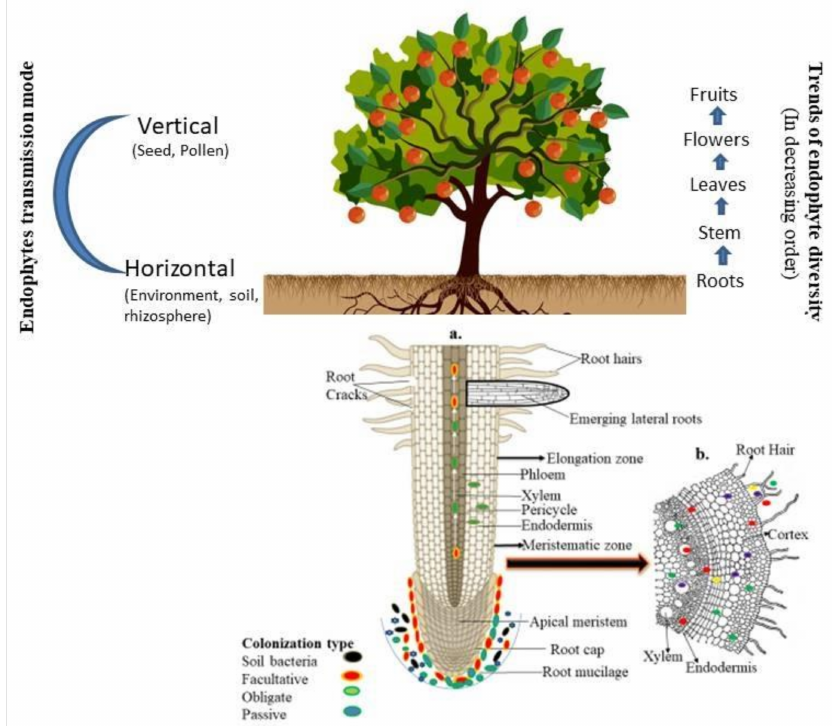
Figure 1. The detailed overview of endophyte biology and their mode of transmission: ( a ) entry of microbial endophytes to the plant tissue by different part of root zones. Arrows show the movement of endophytes; ( b ) occurrence of endophytes either at the entry site or in the intercellular spaces. Part of a figure has been taken from Kumar et al.